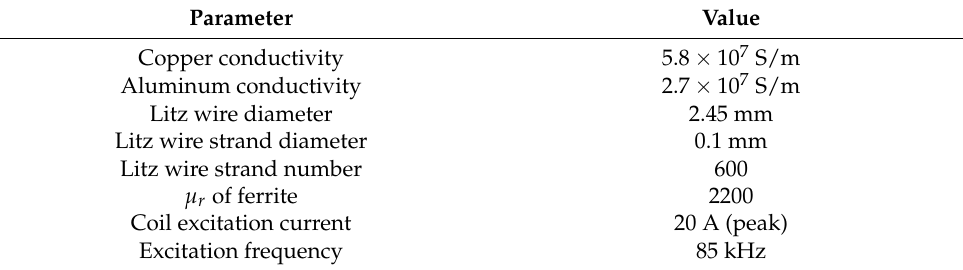
Table 1. Parameter settings in the Maxwell